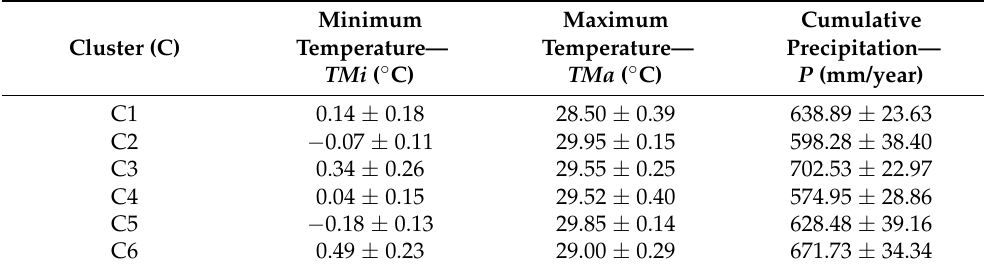
Table 3. Statistics concerning climatic features of clusters—minimum temperature ( TMi , ◦ C), maxi- mum temperature ( TMa , ◦ C), and cumulative precipitation ( P , mm/year).